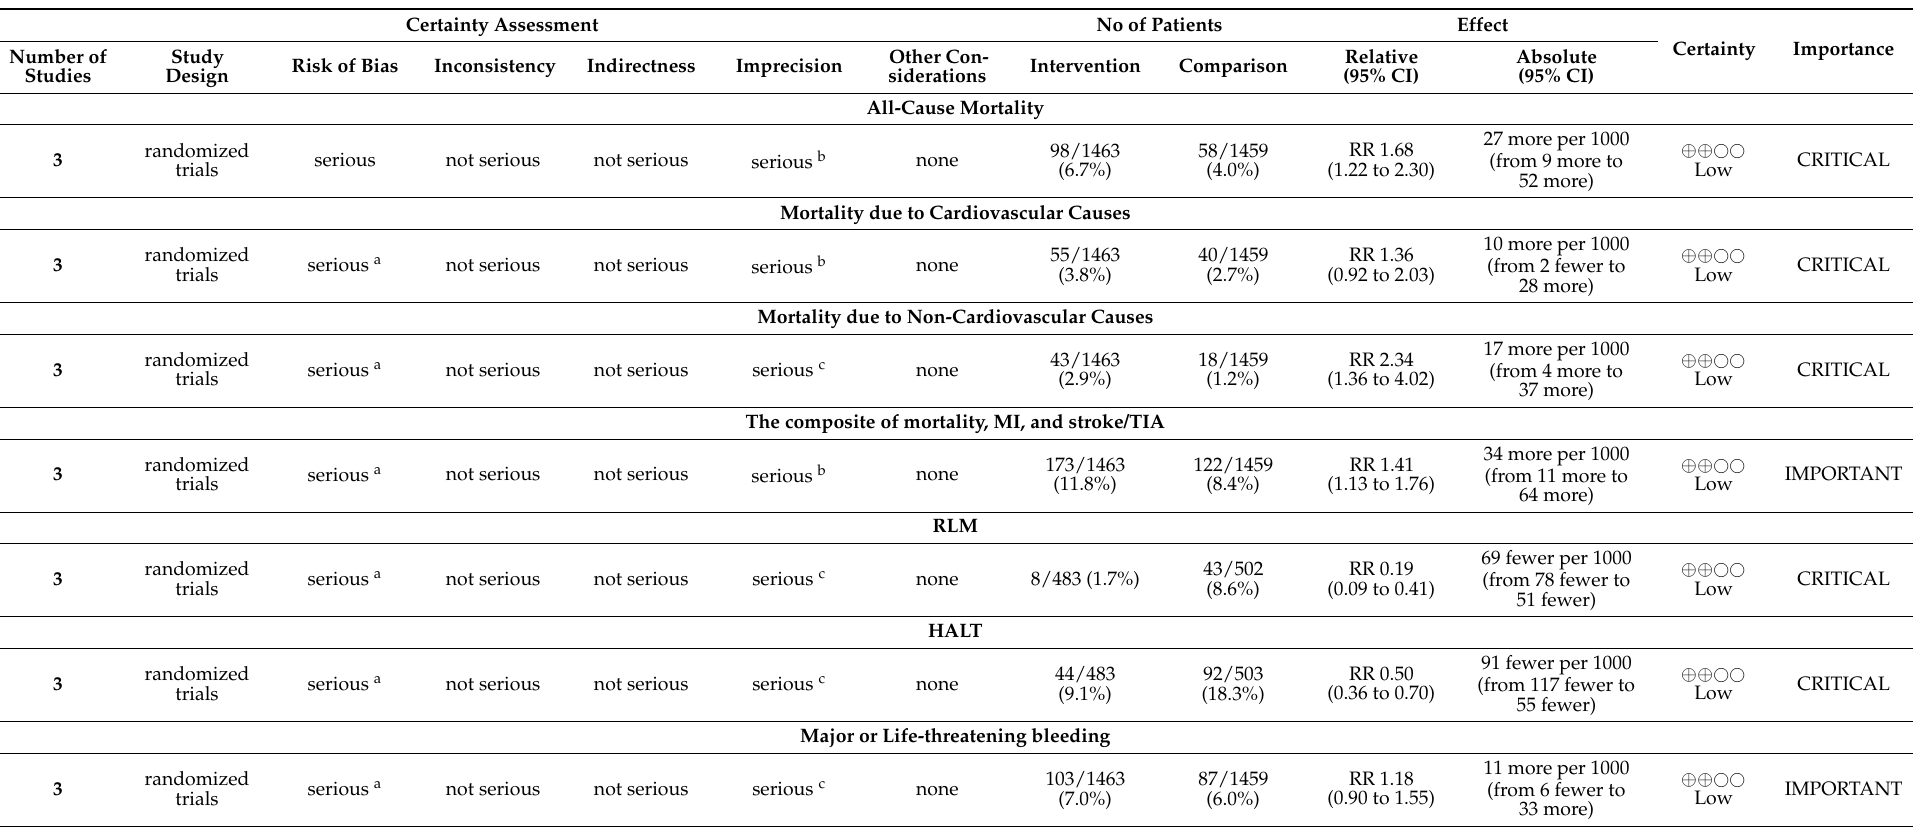
Table 4. GRADE evidence